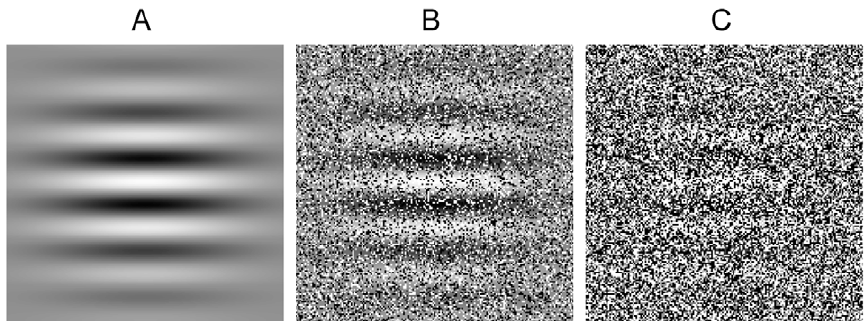
Figure 1. Illustration of ‘‘dot-view’’ stimulus generation. A) Target waveforms consisted of Gabor patterns or gratings. These were masked by replacing a proportion of the pixels depicting target waveforms (signal elements) with pixels depicting static white noise (noise elements). Signal elements can be thought of as windows, through which target waveforms can be seen. In this class of stimulus, the visibility of target waveforms can be adjusted by manipulating the proportion of signal elements to noise elements. B) Depiction of dot-view stimulus signal-to-noise ratio (SNR; proportion signal elements divided by proportion noise elements) 1.5. C) Depiction of dot-view stimulus SNR 0.33.